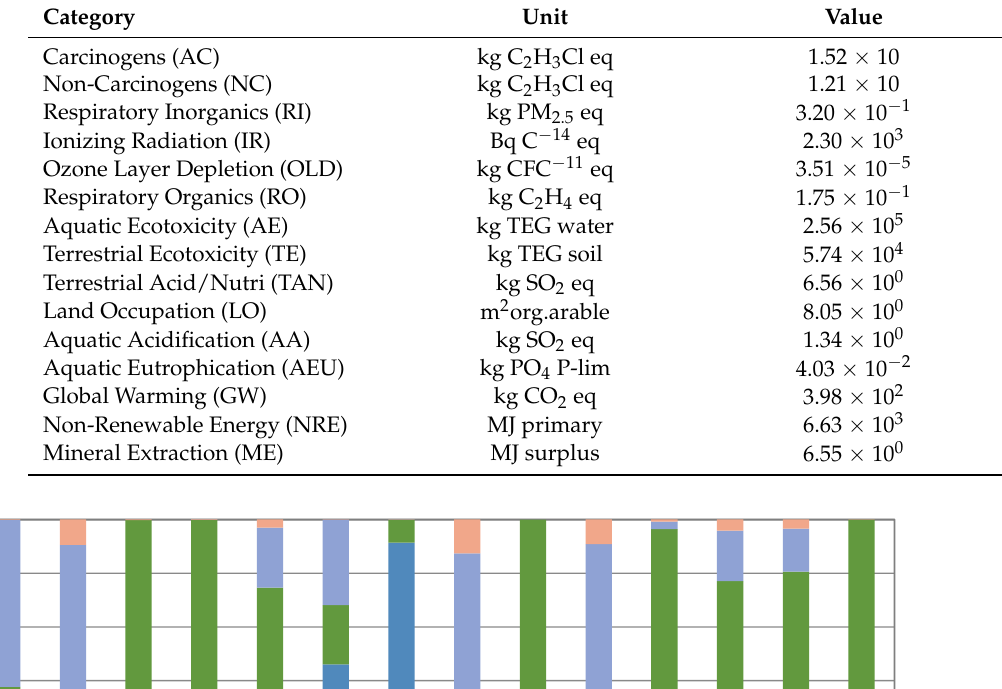
Table 5. LCA midpoint indicators.